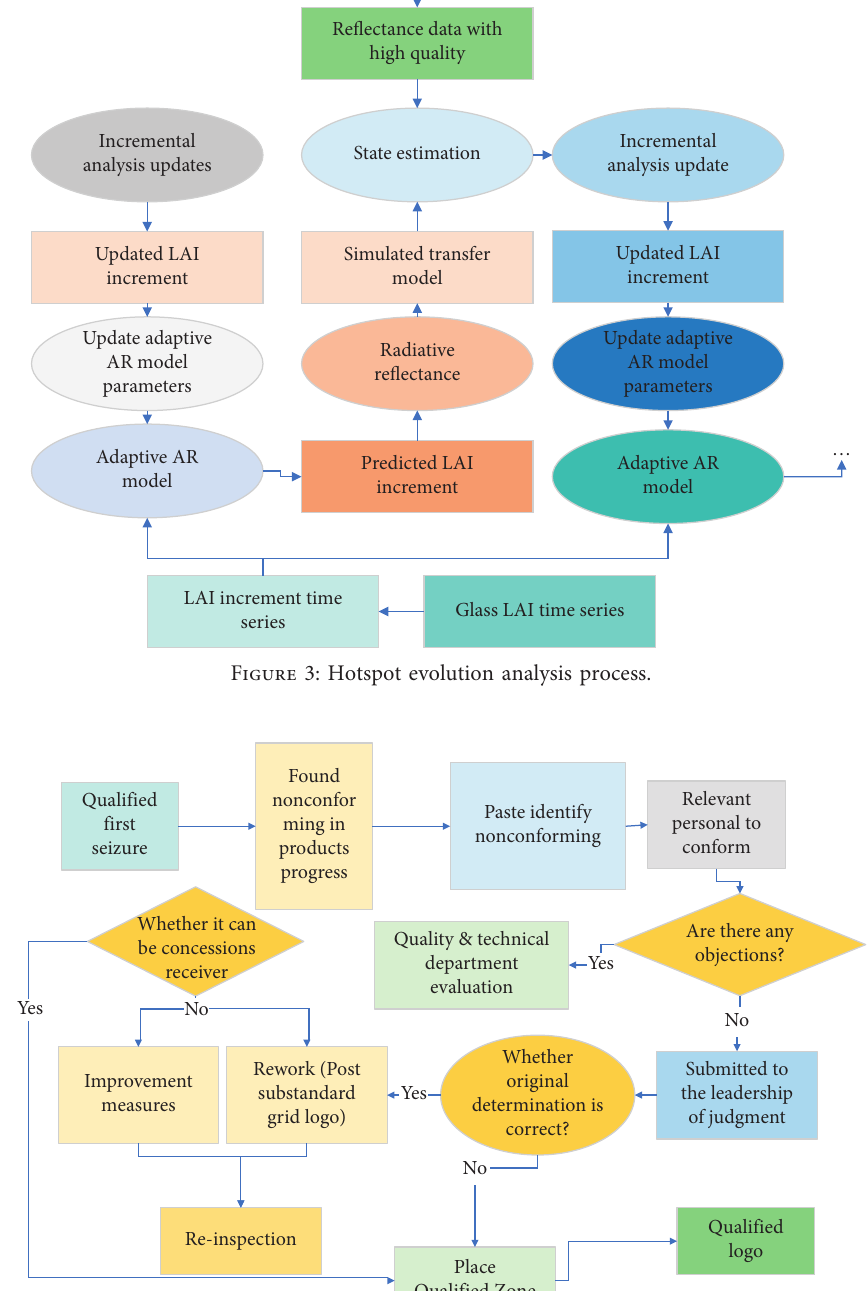
Figure 4: The process of constructing a topic hot index